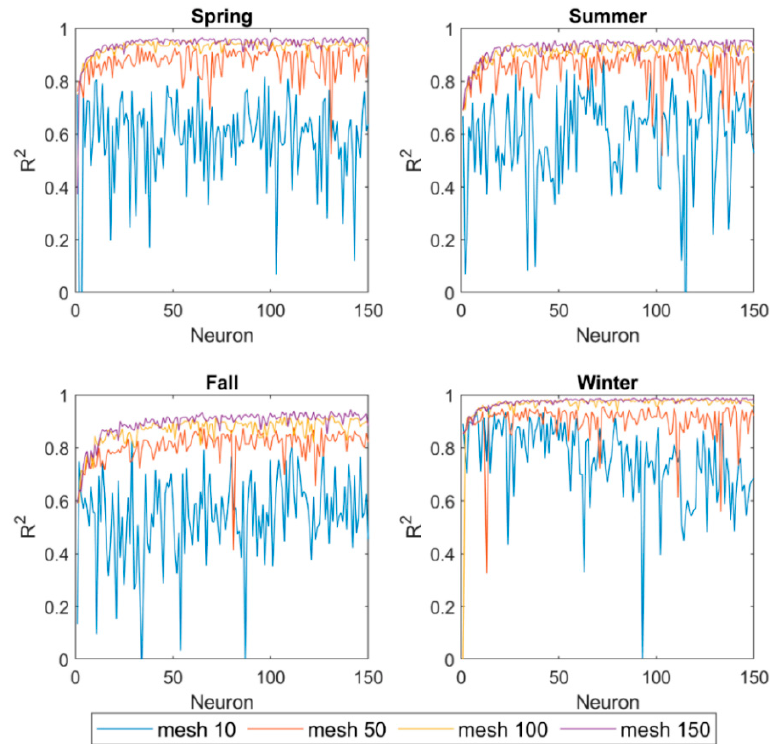
Figure 5. The variation of R (cid:2870) with respect to the number of neurons for grids 10, 50, 100 and 150.